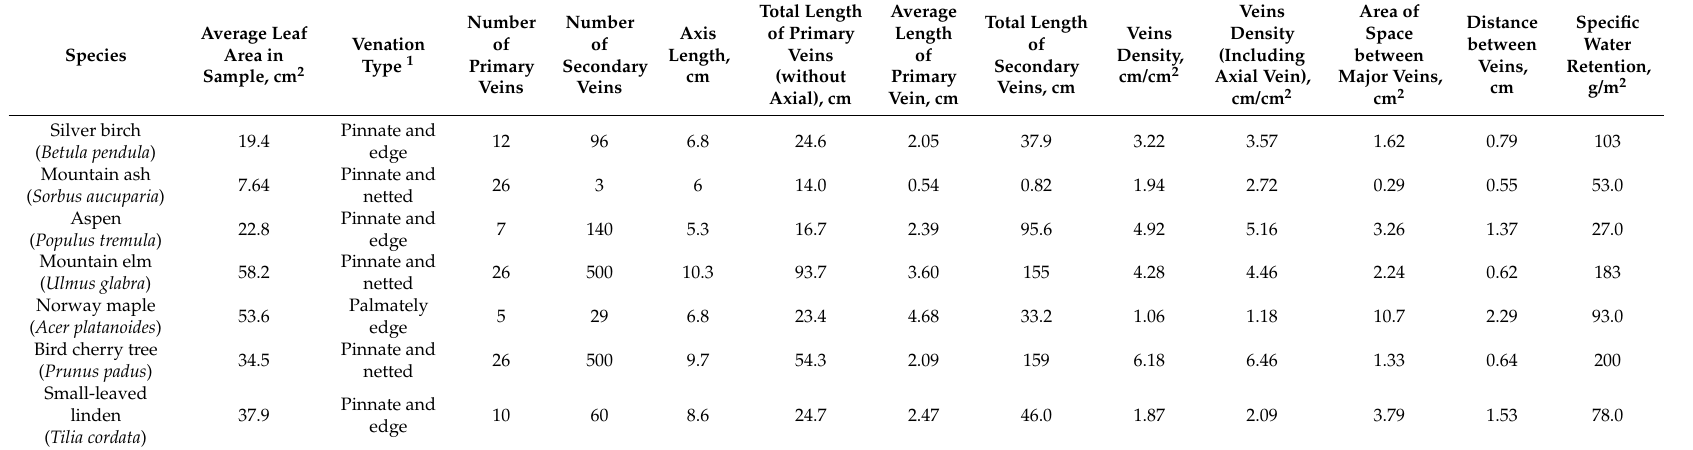
Table 2. Quantitative characteristics of the venation of leaves from samples of the analyzed deciduous